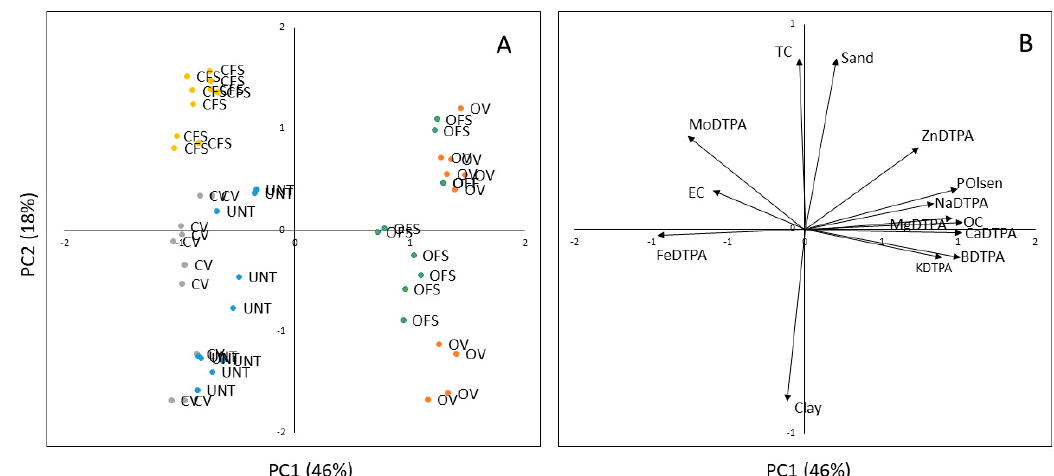
Figure 1. Positions of soil samples (OV, organic vineyard; OFS, organic field-scale; CV, conventional vineyard; CFS, conventional field-scale; UNT, untreated = control) in the reduced space of the first two principal components after principal components analysis ( A ). Variables projected in the plane determined by the first two principal components ( B ): Ca DTPA , calcium DTPA extractable; B DTPA , borum DTPA extractable; OC, organic carbon; Mg DTPA , magnesium DTPA extractable; Fe DTPA , iron DTPA extractable; POlsen, phosphorus Olsen extractable; Na DTPA , sodium DTPA extractable; K DTPA ,